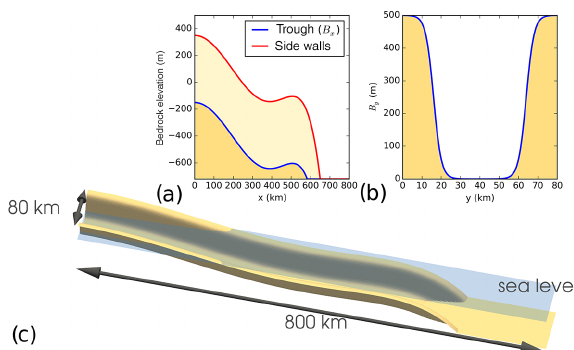
Figure 1. The bedrock topography for the three MIPs as defined by Eqs. (1)–(4). (a) The variability of the bedrock topography in the x direction. The topography through the central trough, B x (x) , is shown in blue and on the side walls is shown in red. (b) B y (y) , the shape of the bedrock topography in the y direction relative to that at the center of the trough. Note that B y (y) is not a transect of the to- pography because B x (x) is never equal to zero. (c) The topography in 3-D at 1km resolution. Sea level is shown in translucent